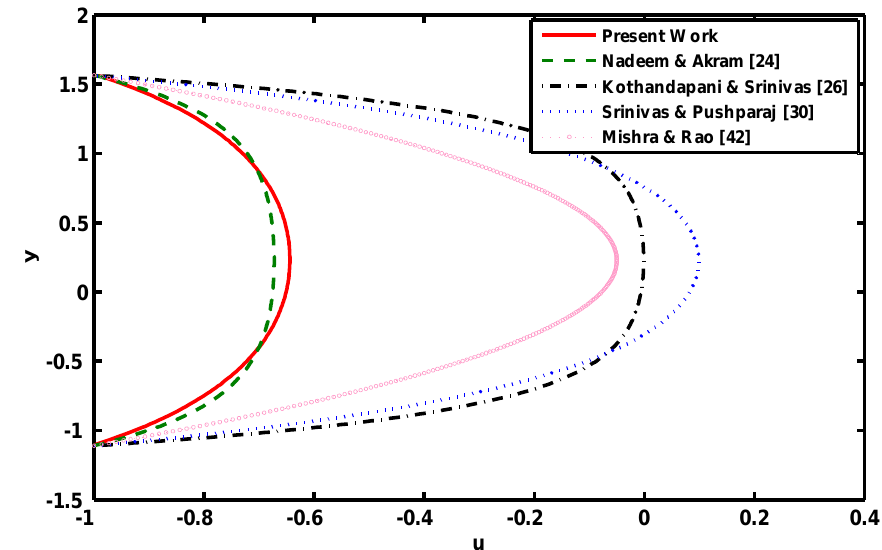
Figure 19. Stream lines fordifferent wave forms. ( a ) for multisinsoidal wave, ( b ) for trapezoidal wave, ( c ) for triangular wave, ( d ) for square wave, ( e ) for sawtooth wave, for fixed a = 0.9, α = 0.3, b = 0.1, π = 0.5, η = 0.4, λ = 0.5, k = 0.1. d = 2, Θ = π , M = 0.5Re = 0.4, ϕ = , Fr = 0.6, η 3 4 1 2 1